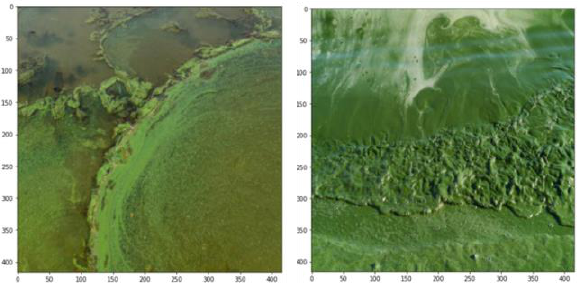
Figure 10. False negatives for algae (not